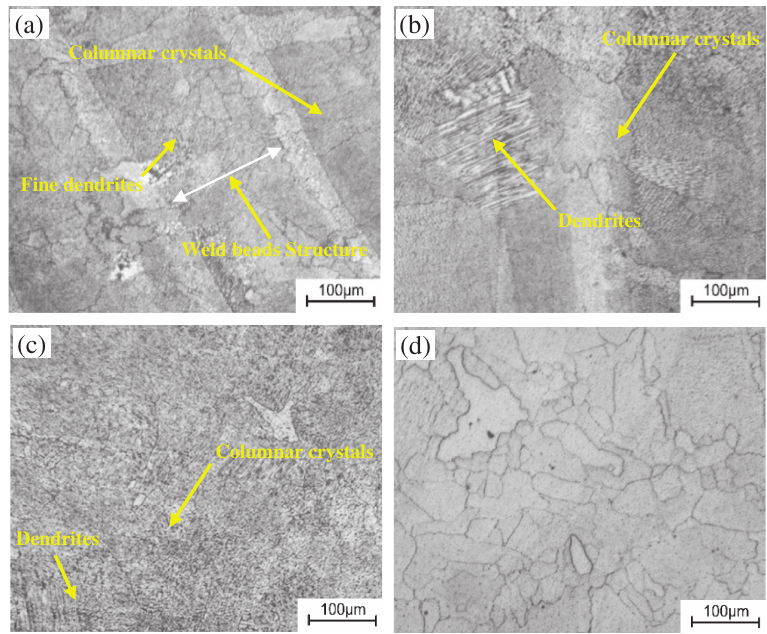
Figure 2: Microstructure on the X-Y surface of Inconel-718 alloys: (a) Microstructure of the as-built alloy, (b) Microstructure of A process, (c) Microstructure of B process and (d) Microstructure of C